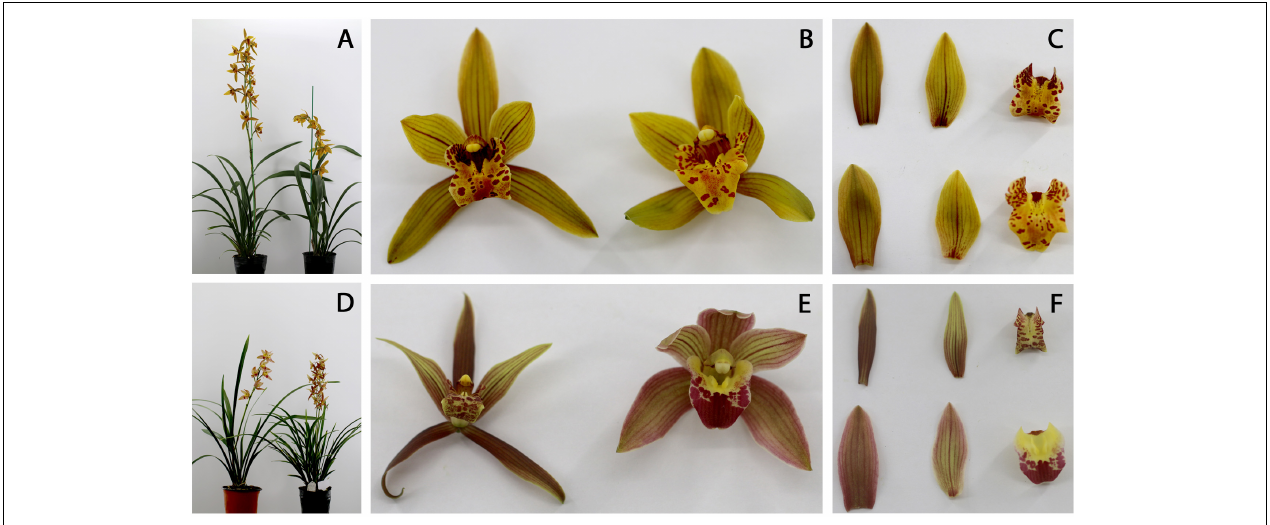
FIGURE 4 | Morphological characteristics of polyploid Cymbidium cultivars with their diploid counterparts. (A) Mature plants of “DH” (left) and “Huanghe” (right). (B) Flowers of “DH” (left) and “Huanghe” (right). (C) Sepals (left), petals (middle), and lips (right) of “DH” (above) and “Huanghe” (below). (D) Mature plants of “XY” (left) and “Yutao” (right); (E) Flowers of “YX” (left) and “Yutao” (right); (F) Sepals (left), petals (middle), and lips (right) of “YX” (above) and “Yutao”